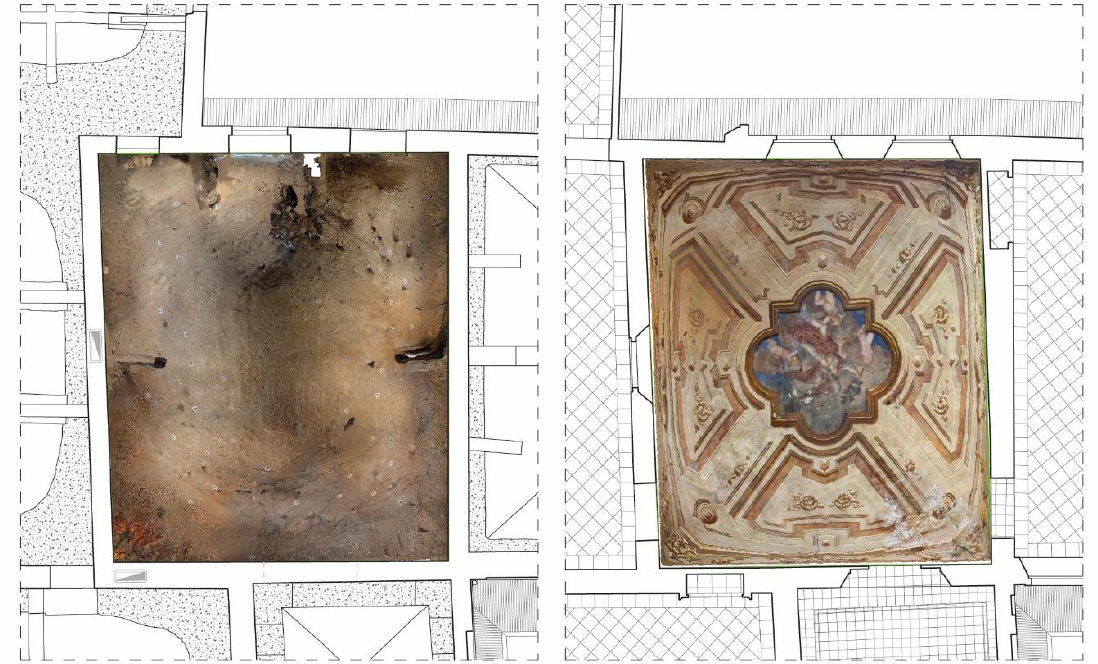
Figure 6. 3D orthoimages of the extrados and the intrados obtained by the photogrammetric image